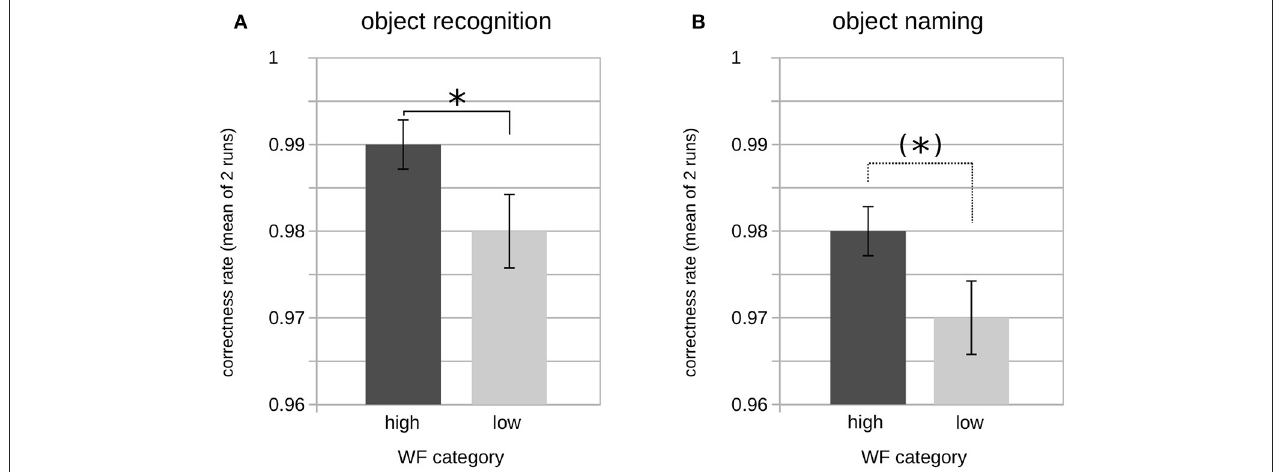
FIGURE 2 | Rates of correct object recognition and naming by word frequency category. Bar plot showing the average correct object recognition (A) and object naming (B) rates of both runs (pooled) by word frequency (WF). Significant differences according to groupwise post-hoc comparison of means are indicated by asterisks [(*) p < 0.1; * p < 0.05]. Please note the limited ranges of the y -axis, for better readability.